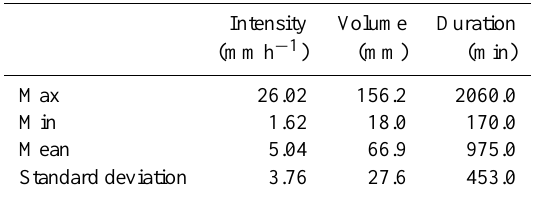
Figure 2. Comparison between empirical joint distribution and best fitted copula. Goodness test for Frank’s copula.